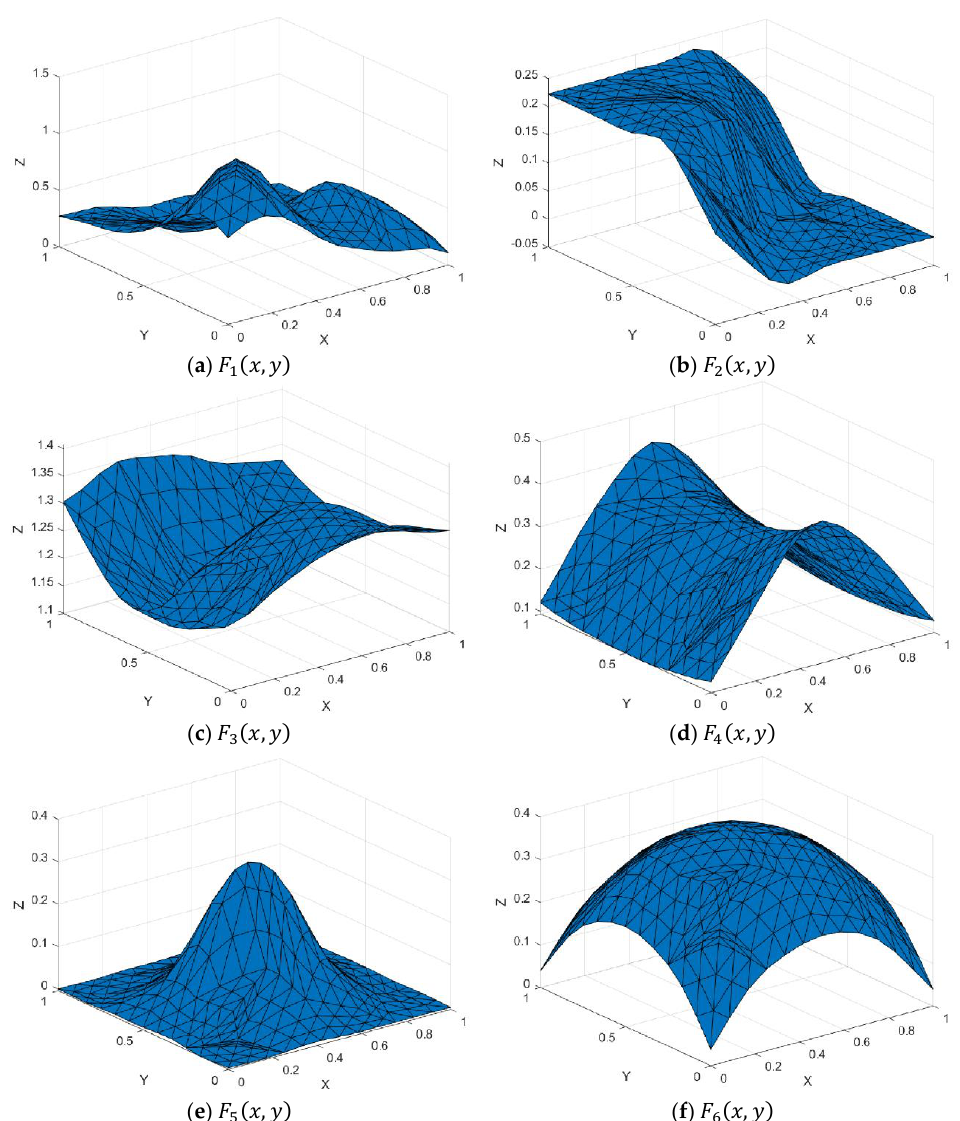
Figure 13. Surface interpolation using Goodman and Said method and Choice 2 for 36 datasets.